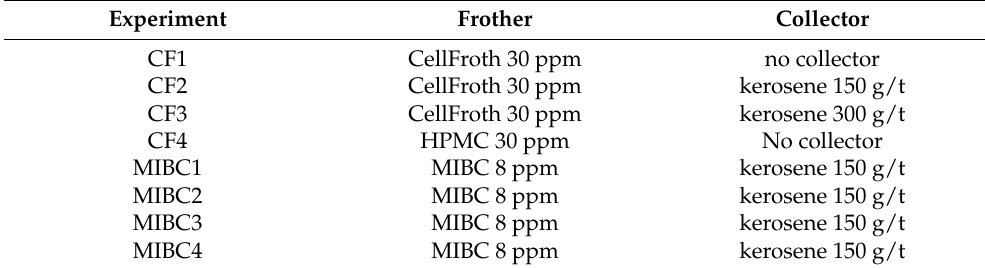
Table 1. The experimental parameters in the flotation campaign. Constant parameters include an aeration rate of 2 L/min and grinding time of 20 min, and black mass particle size of >500 µ m. Experiment Frother Collector CF1 CellFroth 30 ppm no collector CF2 CellFroth 30 ppm kerosene 150 g/t CF3 CellFroth 30 ppm kerosene 300 g/t CF4 HPMC 30 ppm No collector MIBC1 MIBC 8 ppm kerosene 150 g/t MIBC2 MIBC 8 ppm kerosene 150 g/t MIBC3 MIBC 8 ppm kerosene 150 g/t MIBC4 MIBC 8 ppm kerosene 150